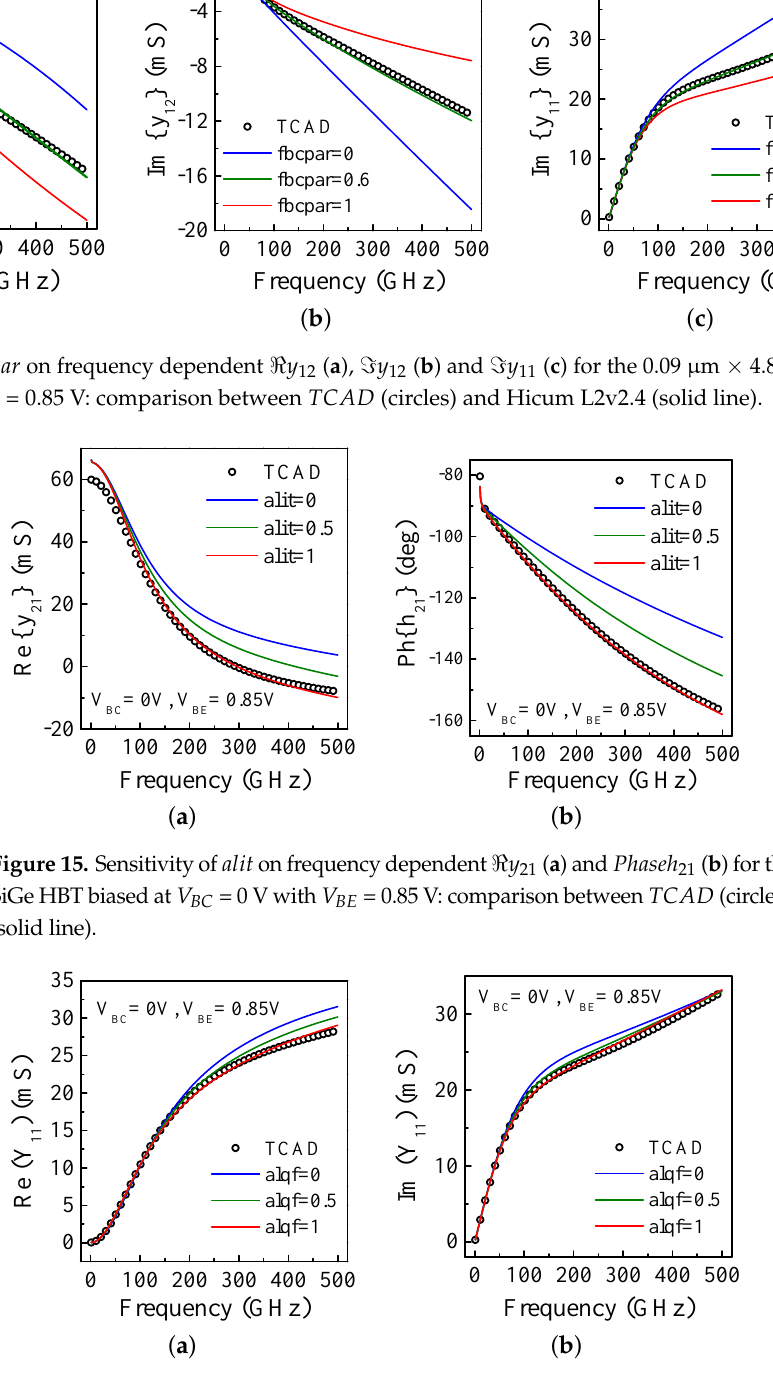
Figure 16. Sensitivity of alqf on frequency dependent (cid:60) y 11 ( a ) and (cid:61) y 11 ( b ) for the 0.09 µ m × 4.8 µ m SiGe HBT biased at V BC = 0 V with V BE = 0.85 V: comparison between TCAD (circles) and Hicum L2v2.4 (solid